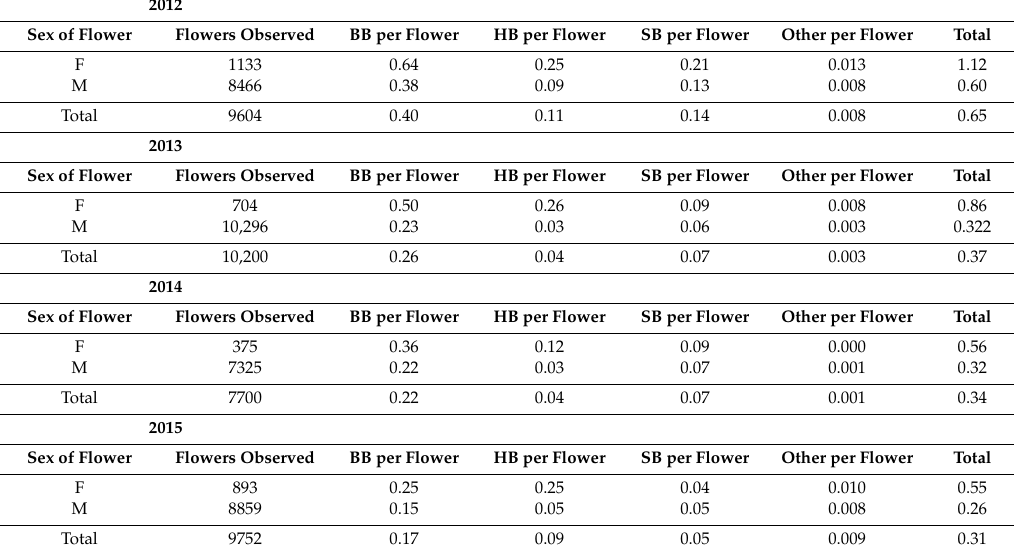
Table 4. Number of flowers of each sex observed in hourly 100 flower bee counts, and the mean bees per flower visiting each flower by species. BB = bumble bee, HB = honey bee, SB = squash bee, Other = other bee species. Mean bees per flower by sex calculated for each site and date and then averaged by